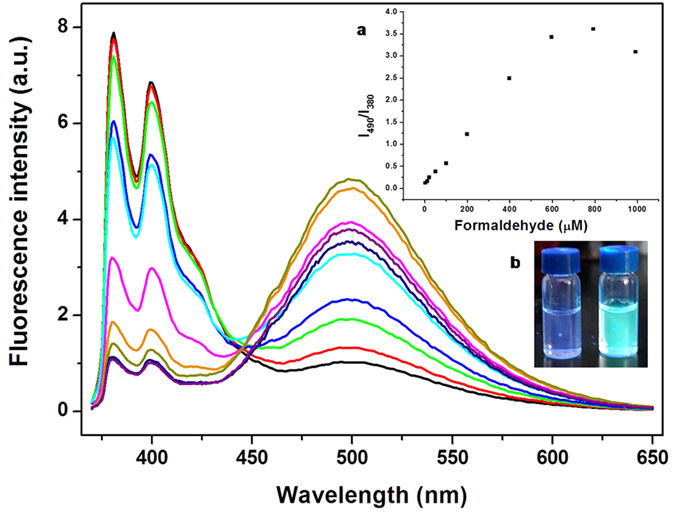
Fluorescence emission spectra of PSNB2-F ([PSNB2] 0.1 mM/[Fructose] 5 mM) in PBS buffer (pH 7.4) in the presence of FA over 0–1 mM.The inserted figures are the plot of I490/I380 against the concentration of FA (a) and the picture of PSNB2-F in the buffer in absence (left) and presence (right) of 1 mM FA (b).